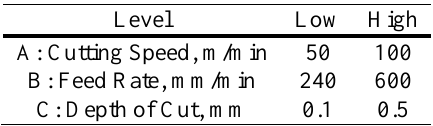
Table 3. Coding of independent variables with their